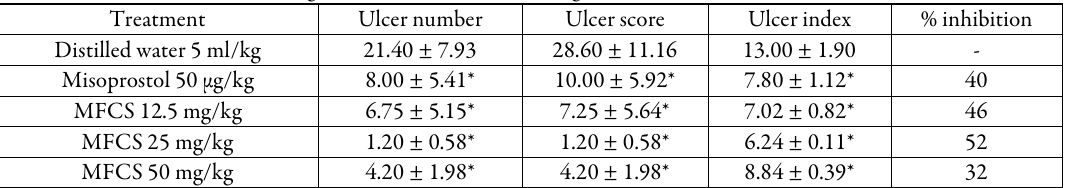
Table 1. Effects of MFCS against indomethacin-induced gastric ulcer Treatment Ulcer number Ulcer score Ulcer index % inhibition Distilled water 5 ml/kg